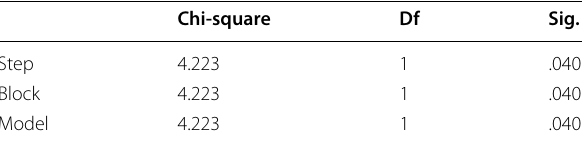
Table M: Omnibus tests of model coefficients for aggressive culture